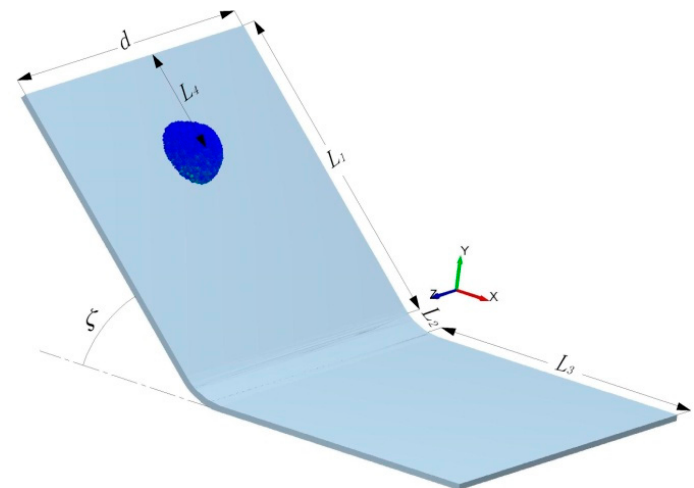
Figure 15. Geometric model of the chute geometry of Case 2.